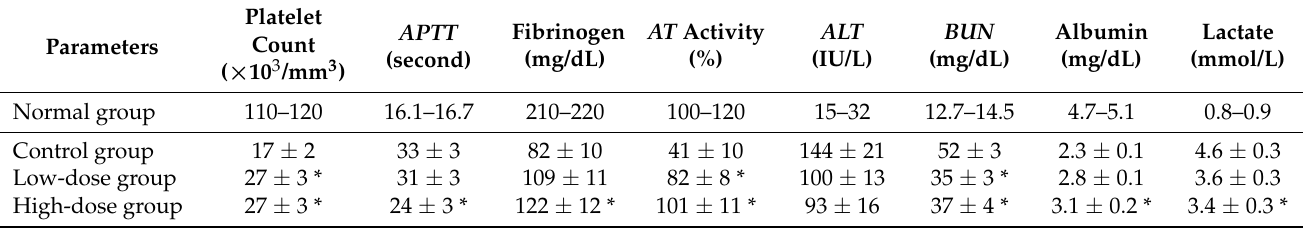
Table 1. Laboratory findings of the endotoxemic rats treated with or without antithrombin.